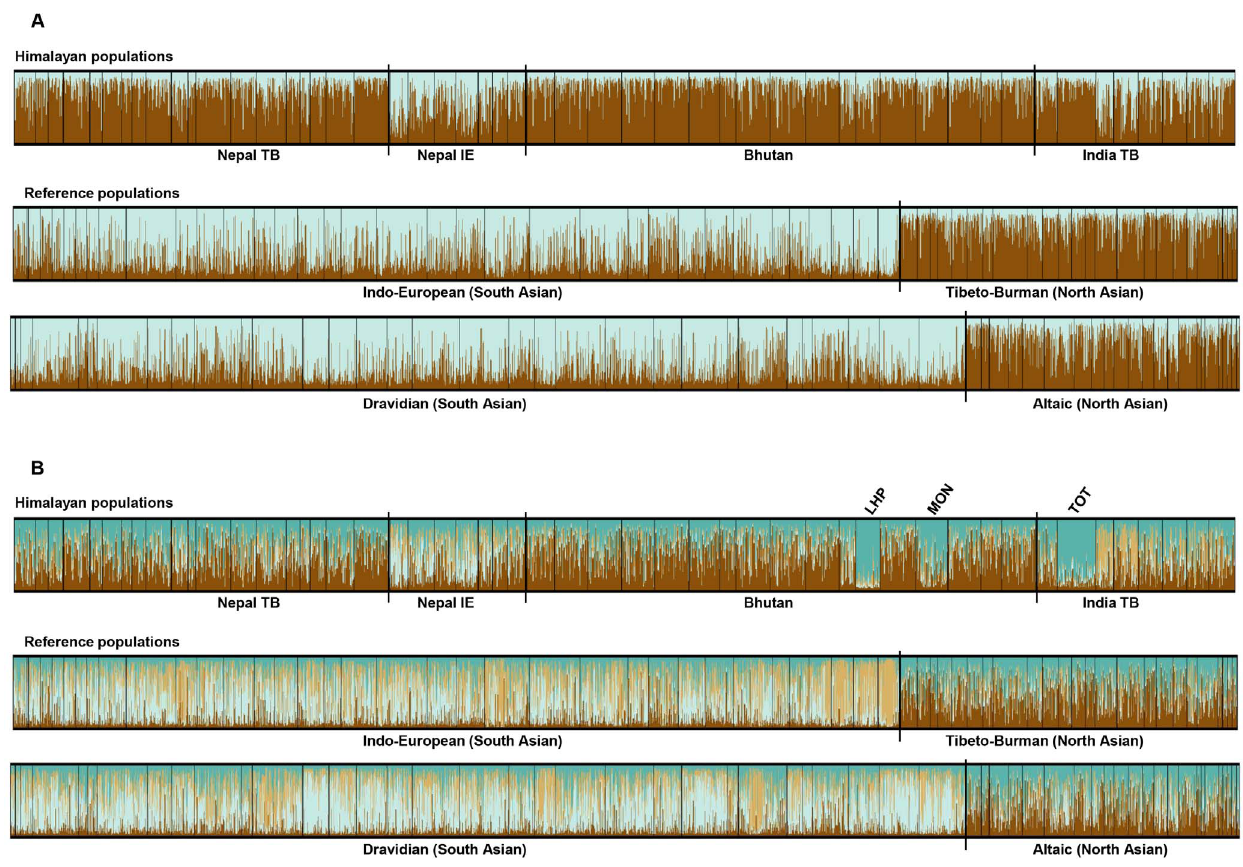
Figure 3. Results of STRUCTURE analyses. The colours represent the proportion of inferred ancestry from K ancestral populations. 3A: Unsupervised run for K=2. The distribution pattern of inferred ancestry seems to indicate the presence of subtle population substructures within the Himalayas, with the Indo-European speaking Himalayan populations clustering more closely to the Indo-European and Dravidian reference populations (predominantly light blue) and the Tibeto-Burman speaking Himalayan populations clustering more closely to the Tibeto-Burman and Altaic reference populations (predominantly brown). 3B: Unsupervised run for K . 2. The clustering pattern as observed for K=2 in the Himalayan populations is mostly lost in favour of the separation of the Lhokpu (LHP), Black Mountain Mo¨npa (MON) and Toto (TOT), although some differences can still be observed between the Tibeto-Burman and Indo-European populations (this figure shows the results for K=4).